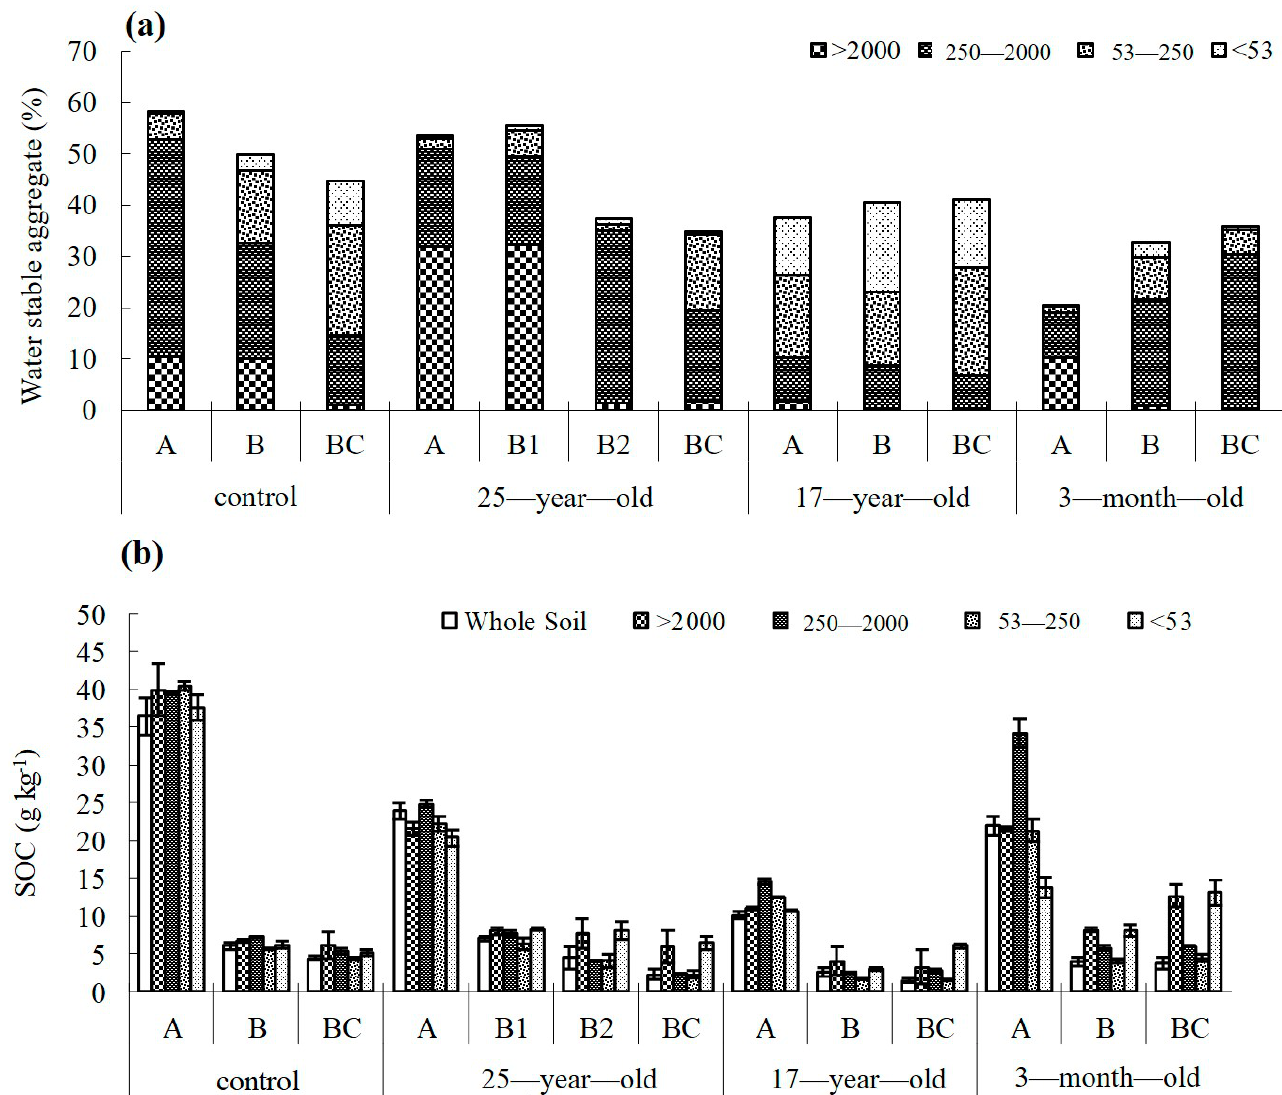
Figure 2. Changes of water stable aggregates (WSA) ( a ) content and ( b ) WSA associated SOC (WSA-SOC) concentrations after wildfire. Ranges of >2000 μ m, 250–2000 μ m, 53–250 μ m, and <53 μ m represent different WSA in size, respectively.